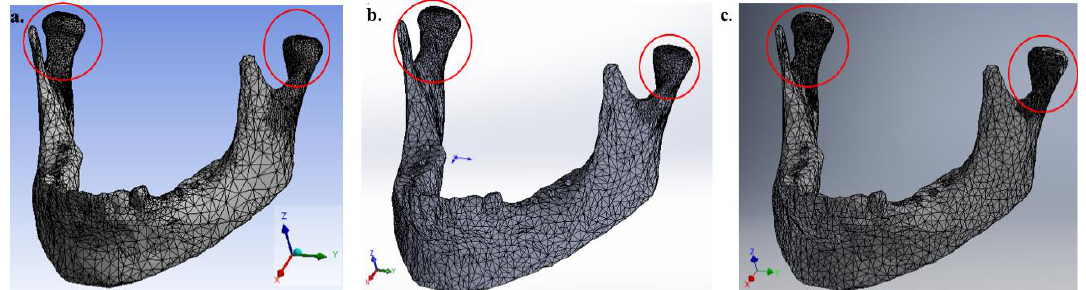
Figure 3. Mesh refinement in the mandible geometry without the molar teeth on the right side: ( a ) Ansys ® , ( b ) SolidWorks ® and ( c ) Inventor ® software.